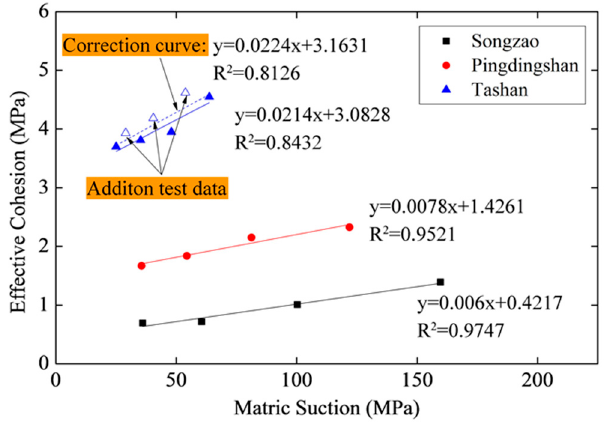
Figure 10. Relationship between effective cohesion and matrix suction.